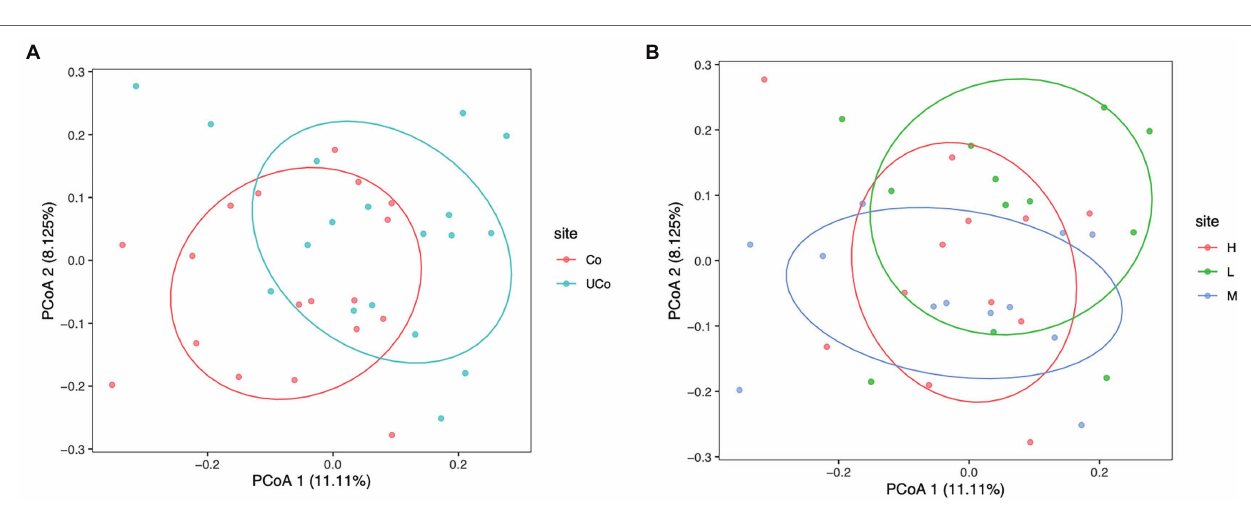
FIGURE 2 | Principal coordinate analysis (PCoA) of cecal samples based on the unweighted UniFrac Distances. (A) The labels of the samples indicate the pattern of trace minerals, Co, coated trace minerals; UCo, uncoated trace minerals. (B) The labels of the samples indicate the supplementation level of trace minerals, L, 300 mg/kg; M, 500 mg/kg; and H, 1,000 mg/kg.